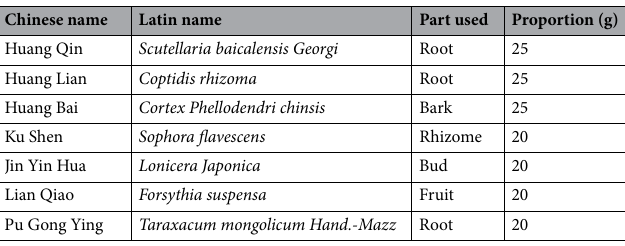
Table 1. The composition of SH